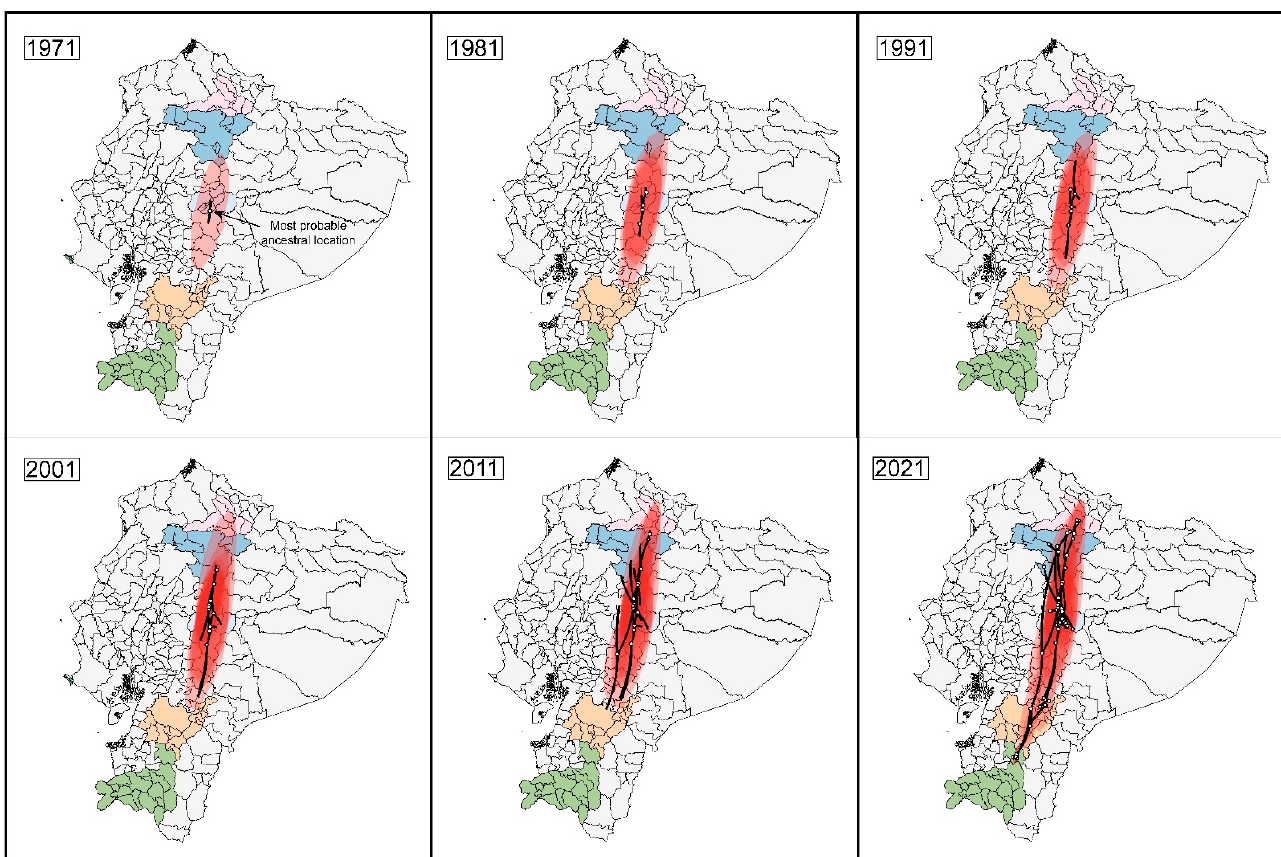
Figure 2. Reconstructed spatiotemporal dynamics of babaco mosaic virus (BabMV) in Ecuador; snapshots showing the viral presence per decade from 1971 to 2021. Black lines show a spatial projection of a representative phylogeny. White circles represent ancestrally estimated geographic locations for nodes in the inferred phylogenetic tree (internal nodes), together with actual locations at tips (external nodes). Colored clouds represent statistical uncertainty in the estimated locations of BabMV lineages (95% HPD intervals). Highland provinces where babaco is grown extensively are colored: pink, Imbabura; blue, Pichincha; light blue, Tungurahua; orange, Azuay; and green, Loja.